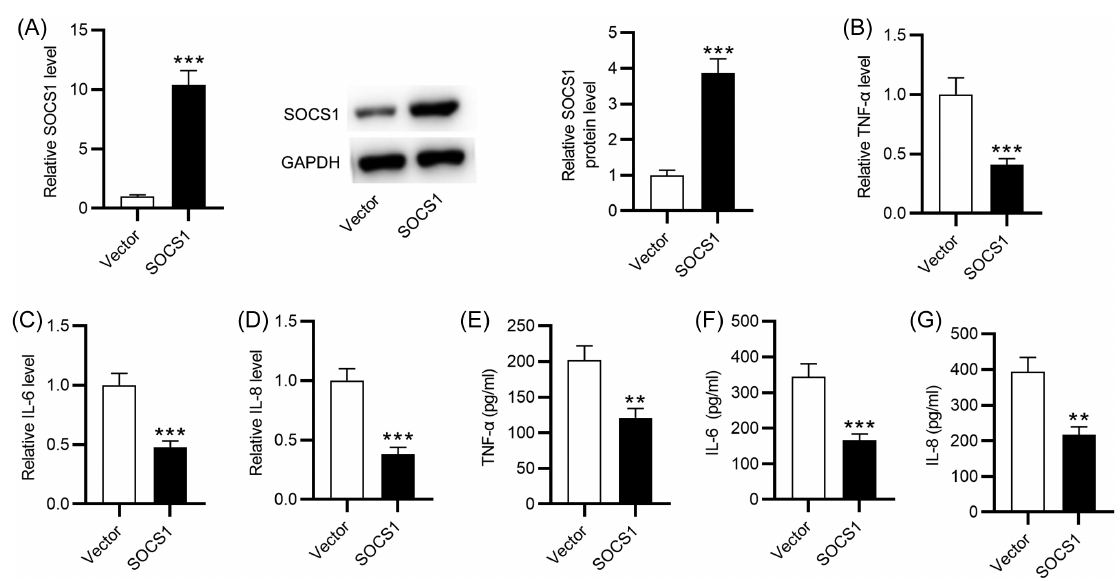
Figure 2. Effects of SOCS1 on inflammation of macrophages. (A) SOCS1 mRNA and protein expression in LPS-treated RAW264.7 cells transfected with SOCS1 or vector was measured by RT-qPCR and western blotting. The mRNA expression of TNF- α (B), IL-6 (C), and IL-8 (D) after transfection with SOCS1 or vector was detected by RT-qPCR. The concentrations of TNF- α (E), IL-6 (F), and IL-8 (G) in LPS- treated RAW264.7 cells transfected with SOCS1 or vector were detected by ELISA. ** P < .01, *** P < .001. LPS, lipopolysaccharide, RT-qPCR, reverse transcription-quantitative polymerase chain